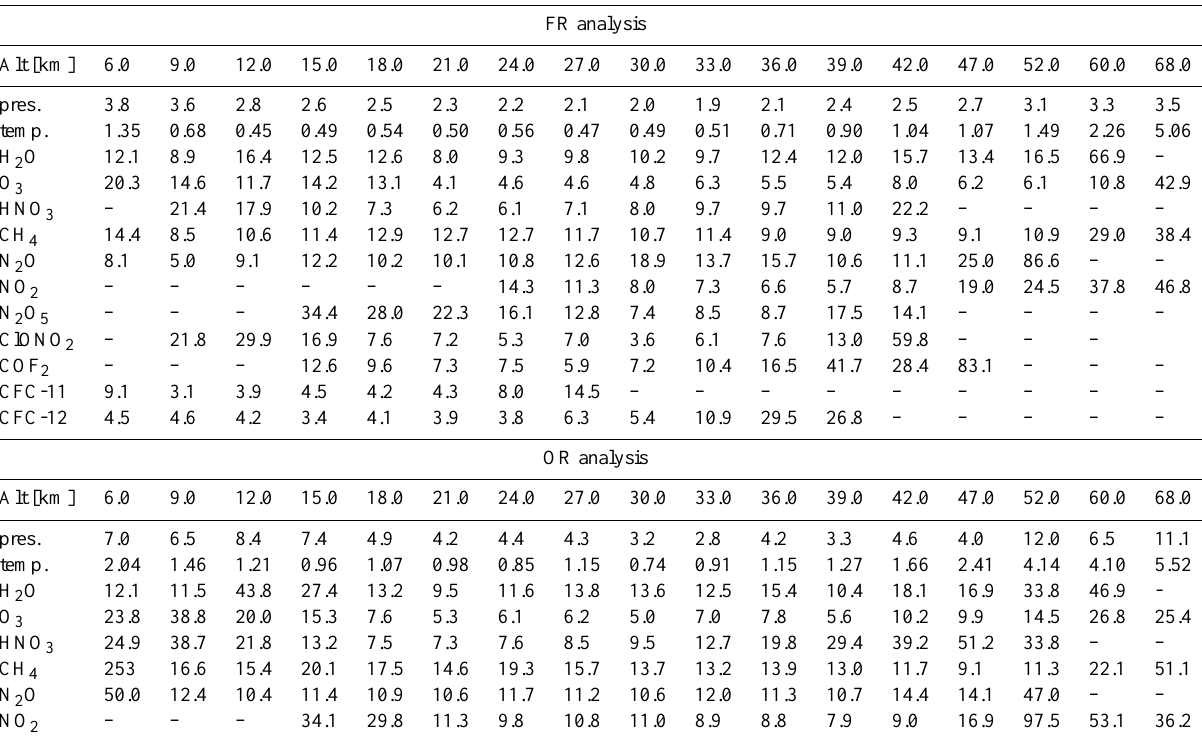
Table 3. Systematic errors affecting the retrieved values. The errors are all given in % apart from temperature errors whose unit is K. Only values for which the estimated random error is below 100% are reported in the